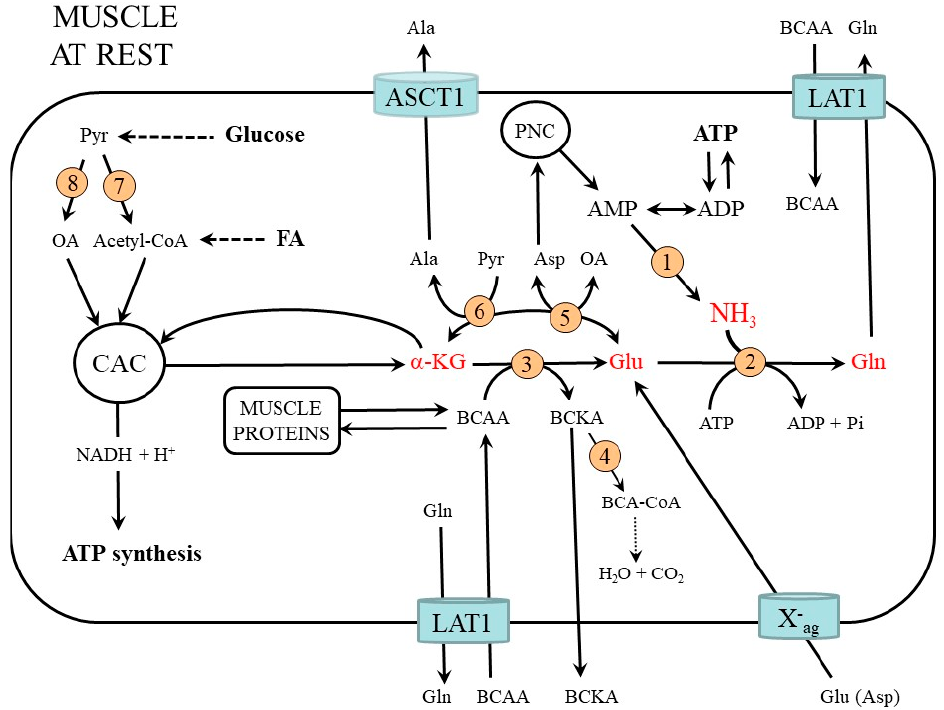
Figure 2. Biochemical pathways and transporters involved in ammonia and amino acid metabolism in skeletal muscle in a physiological state at rest. 1, AMP deaminase; 2, glutamine synthetase; 3, BCAA aminotransferase; 4, BCKA dehydrogenase; 5, AST; 6, ALT; 7, pyruvate dehydrogenase; 8, pyruvate carboxylase. ASCT1 (alanine, serine, cysteine, and threonine carrier 1); BCAA, branched- chain amino acids; BCA-CoA, branched-chain acyl-CoA; BCKA, branched-chain keto acids; FA, fatty acids; LAT1, large neutral amino acid transporter 1; OA, oxaloacetate; X -ag , a transporter for aspartate and glutamate.